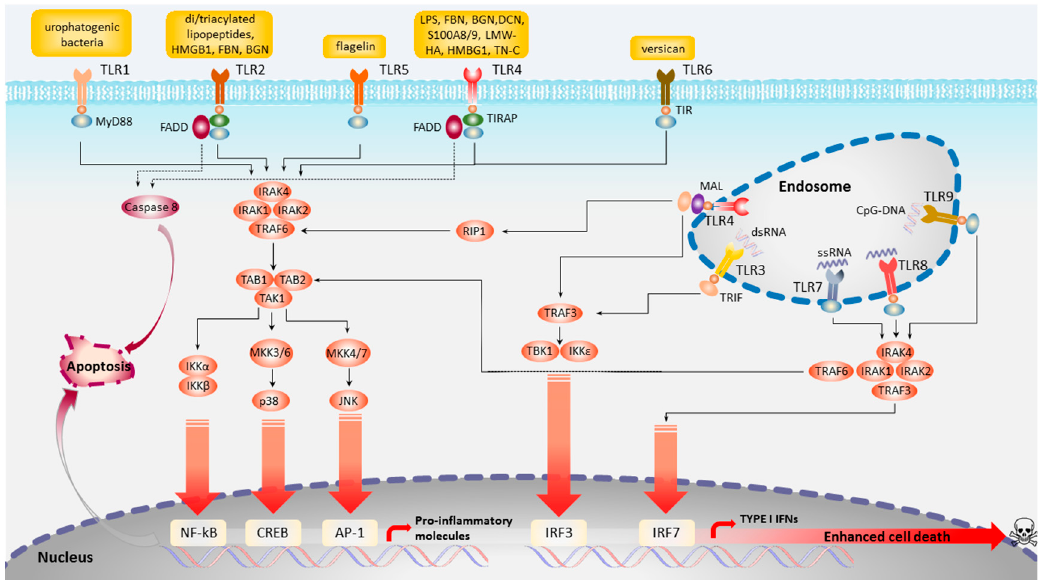
Figure 2. Diagrammatic representation of toll-like receptors (TLR) signaling pathways. AP-1, activator protein 1; BGN, biglycan; CpG-DNA, oligodeoxynucleotides DNA; CREB, cAMP-responsive element-binding protein; DCN, decorin; dsRNA, double-stranded RNA; FADD, FAS-associated death domain; FBN, fibronectin; HMBG1, high-mobility group box 1; I κ B α , inhibitor of NF- κ B α ; IKK, inhibitor of NF- κ B kinase; IRAK, interleukin-1 receptor-associated kinase; IRF, IFN-regulatory factor; LPS, lipopolysaccharide; LMW-HA, low molecular-weight hyaluronic acid; MAL, MYD88 adaptor-like protein; MD2, myeloid differentiation factor 2; MEK, mitogen-activated protein kinase/ERK kinase; MKK, mitogen-activated protein kinase; NF- κ B, nuclear factor- κ B; PI3K, phosphoinositide 3-kinase; RIP1, receptor-interacting protein 1; S100A8/9, S100 calcium-binding protein A 8 and 9; ssRNA, single-stranded RNA; TAB, TAK1-binding protein; TAK1, TGF β -activated kinase 1; TN-C, tenascin-c; TRAF, tumor necrosis factor receptor-associated factor; TRAM, TRIF-related adaptor molecule.